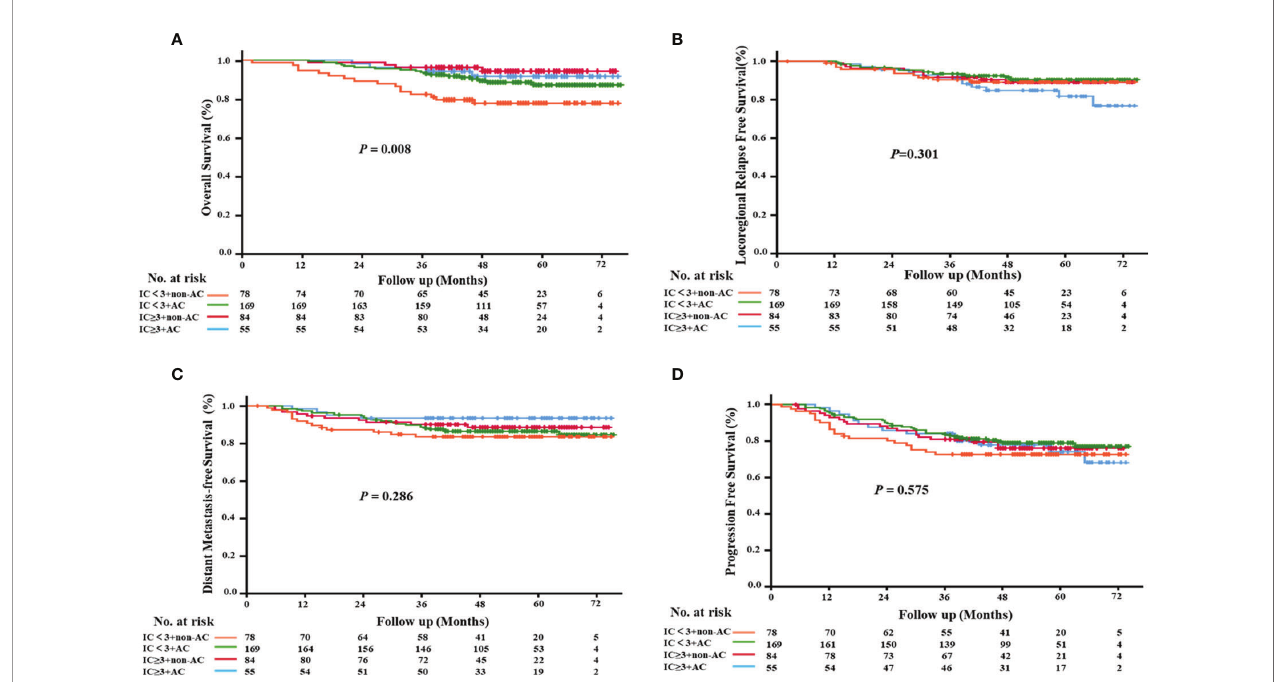
FIGURE 5 | Kaplan – Meier survival curves of the four treatment modalities. (A) overall survival; (B) locoregional relapse-free survival; (C) distant metastasis-free survival; (D) progression-free